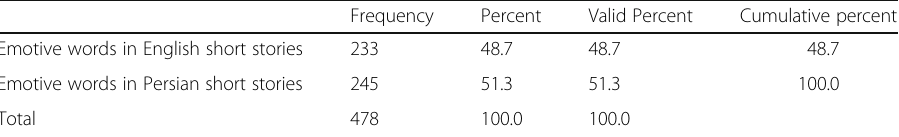
Table 1 Descriptive Statistics of EWs Frequencies in English and Persian Short Stories Frequency Percent Valid Percent Cumulative